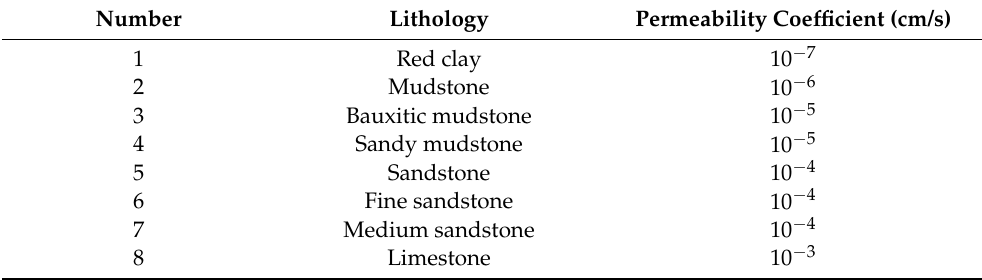
Table 5. The permeability coefficient of the overlying